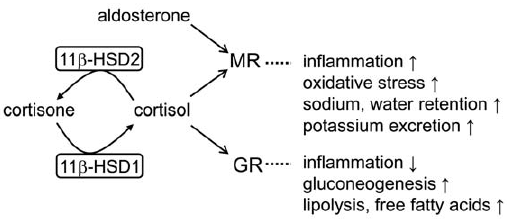
Figure 1. Schematic overview of corticosteroid receptor regulation by 11 b -HSD